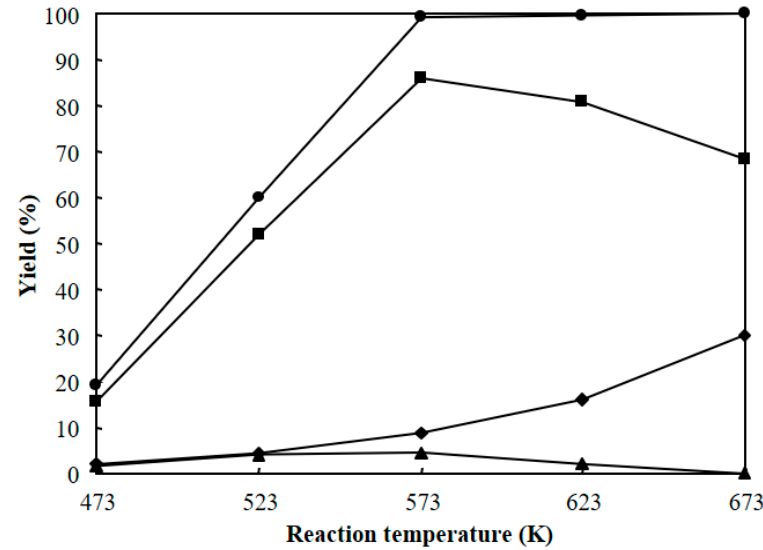
Figure 9. E ff ect of reaction time on the hydrocracking of polyethylene over Pt / Al / MCM-48 at 573 K. Figure 9. Effect of reaction time on the hydrocracking of polyethylene over Pt/Al/MCM-48 at 573 K. Reactions 2020 , 3 , x FOR PEER REVIEW 12 of 14 ( • ): total yield of C 1 –C 21 , ( (cid:7) ): C 1 –C 8 yield, ( (cid:4) ): C 9 –C 15 yield, ( (cid:78) ): C 16 –C 21 yield. ( ● ): total yield of C 1 ‒ C 21 , ( ♦ ): C 1 ‒ C 8 yield, ( ■ ): C 9 ‒ C 15 yield, ( ▲ ): C 16 ‒ C 21 yield.